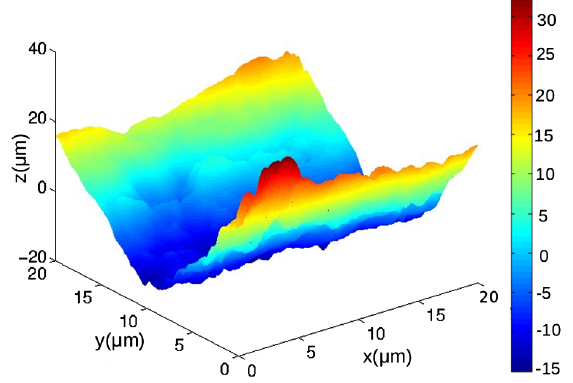
FIG. 10. Raw surface image scan of a 20 μ m by 20 μ m area of aluminum sample #2.